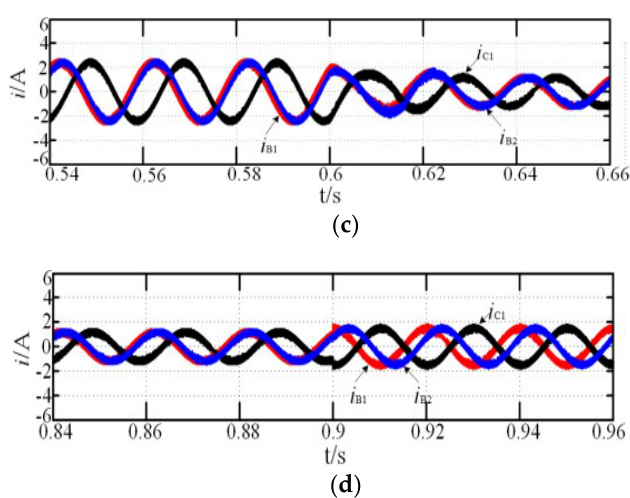
Figure 5. Simulation of fault-tolerant operation: ( a ) MTO; ( b ) magnification of M region; ( c ) magnification of N region; ( d ) magnification of P region.